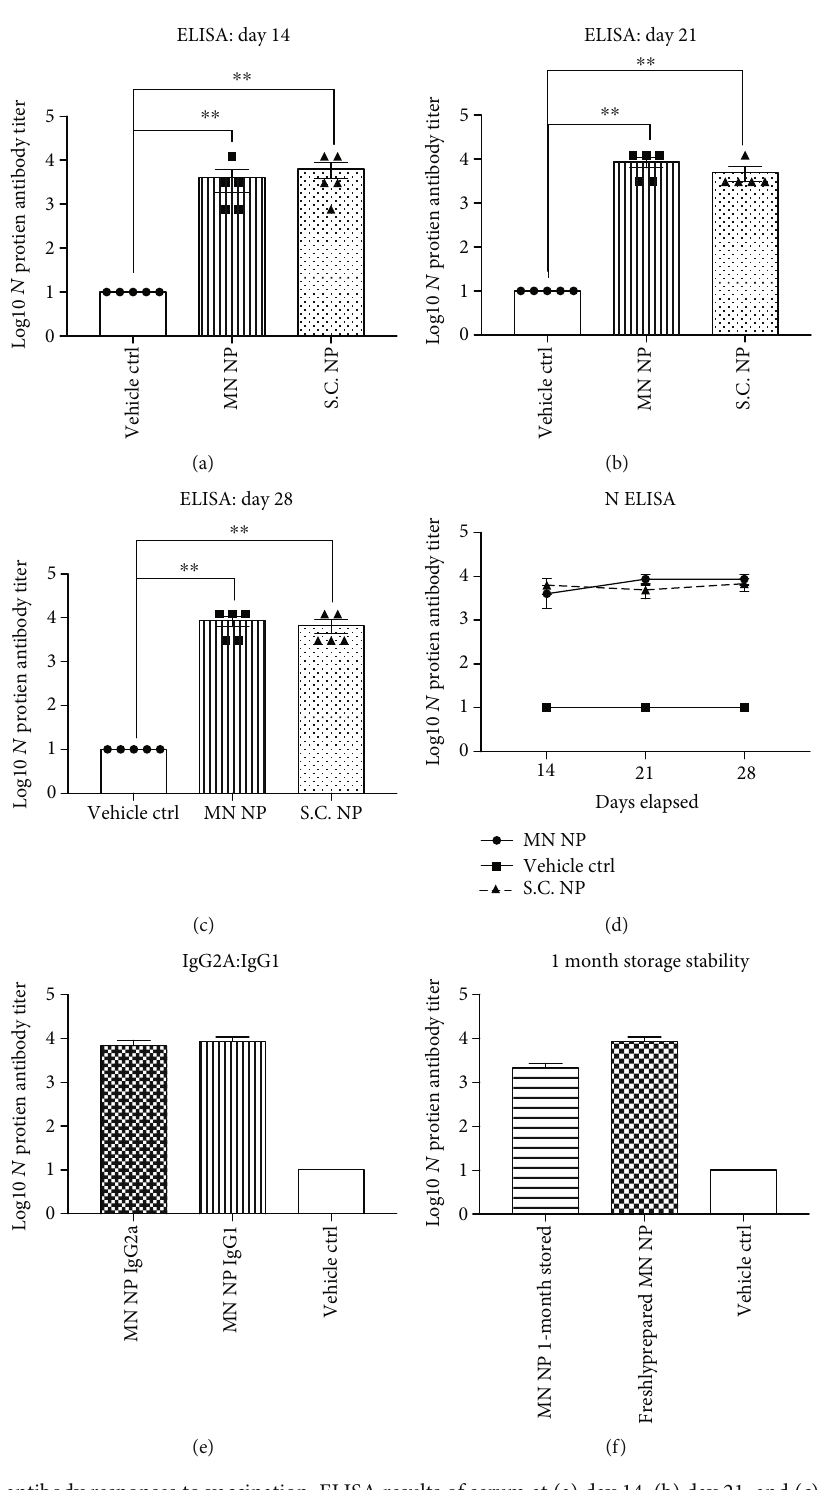
Figure 2: Speci fi c B cell antibody responses to vaccination. ELISA results of serum at (a) day 14, (b) day 21, and (c) day 28 postvaccination, showing log10 antibody titers against the N protein in the S.C. NP immunization group, MN NP immunization group, and vehicle-control group. (d) Summary of log10 mean NP antibody titers from S.C. NP, MN NP, and vehicle-control MN groups. (e) ELISA results of serum at day 28 postvaccination, showing log10 IgG1 and IgG2A antibody titers against the N protein in the MN NP immunization group. (f) ELISA results of mice serum at day 28 postvaccination, showing log10 antibody titers against NP in the freshly prepared MN NP immunization group, 1 month stored MN NP immunization group and vehicle-control group. ELISA absorbance measurements at 450nm were normalized to standard cut-o ff values. Student ’ s unpaired nonparametric t -test (Mann – Whitney) was used with multiple t -test adjustment. Data were expressed as mean ± SEM . ∗ P < 0 : 05 , ∗∗ P < 0 : 01 , ∗∗∗ P < 0 : 001 , ∗∗∗∗ P < 0 : 0001 , ns refers to “ not signi fi cant ”